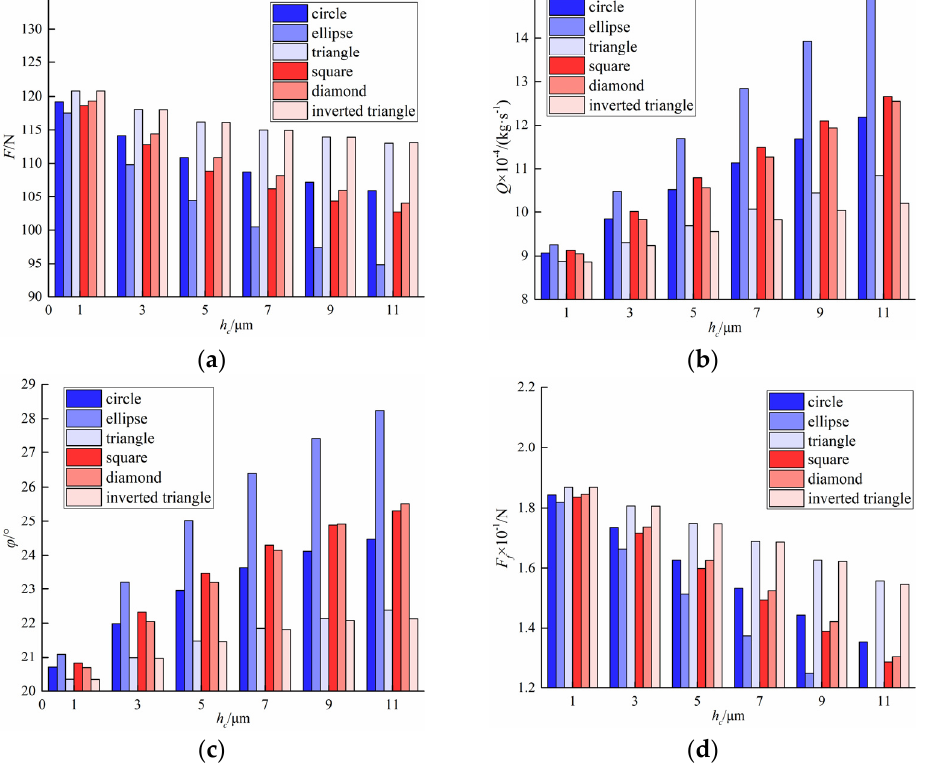
Figure 9. ( a ) Description of force with depth; ( b ) Description of leakage with depth; ( c ) Description of attitude angle with depth; ( d ) Description of friction with depth.